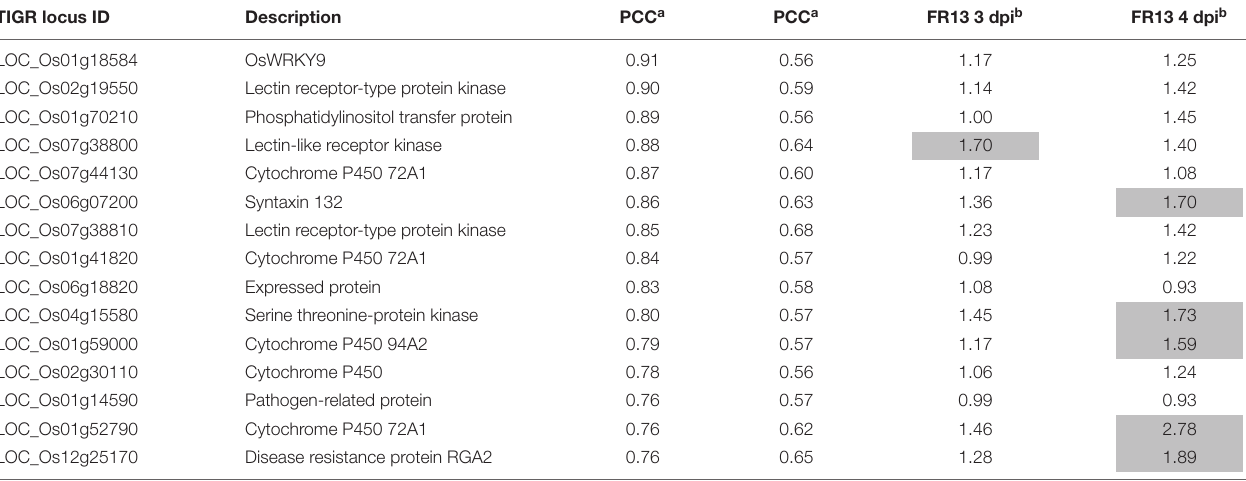
TABLE 2 | Co-expressed genes simultaneously identified in CREP and PLANEX databases. TIGR locus ID Description